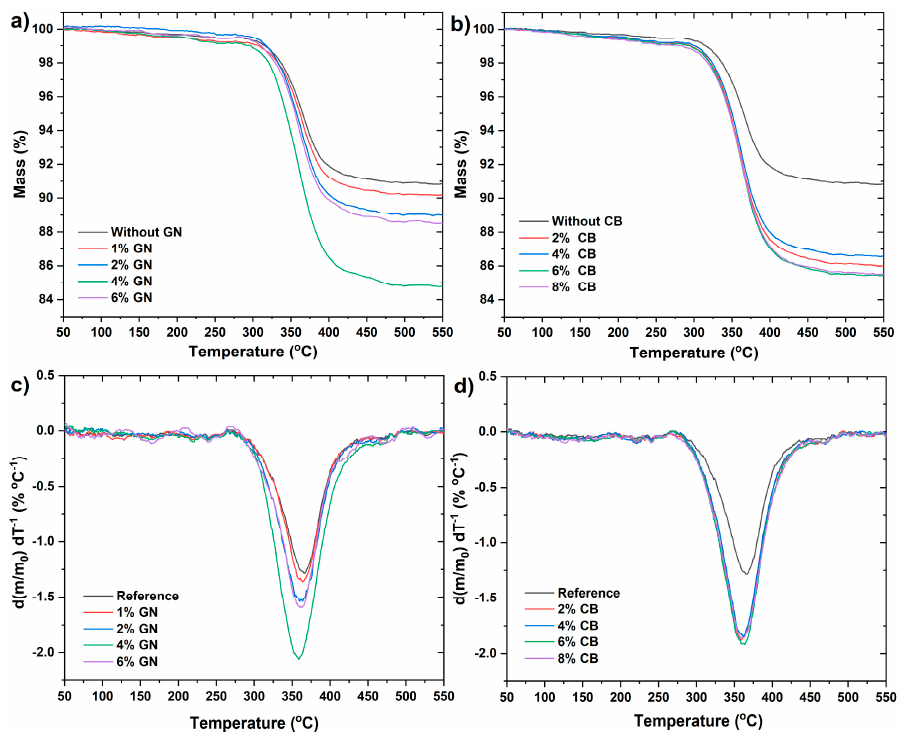
Figure 7. TG and DTG curves of EP/SG composites containing graphene nanoplatelets ( a , c ) and carbon black ( b , d ).